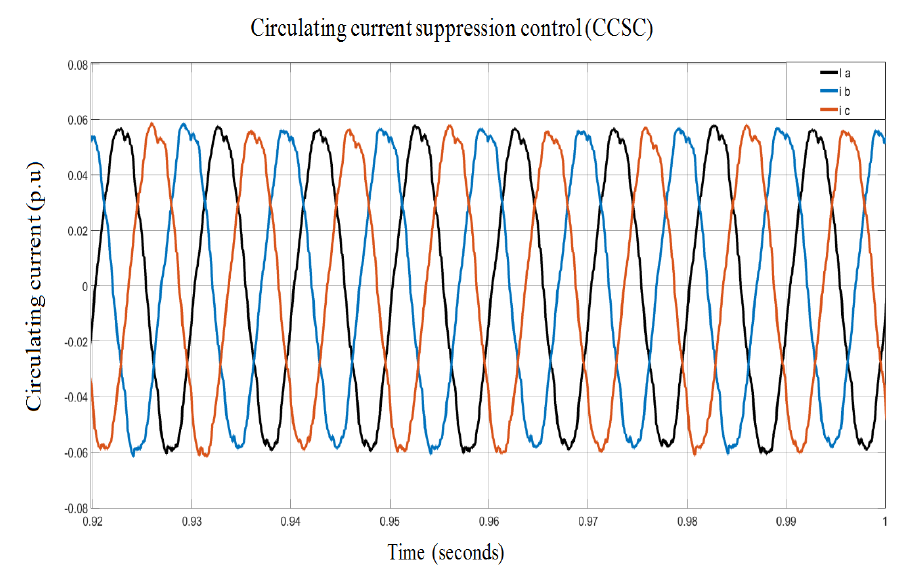
Figure 17. Circulating current suppression control of the